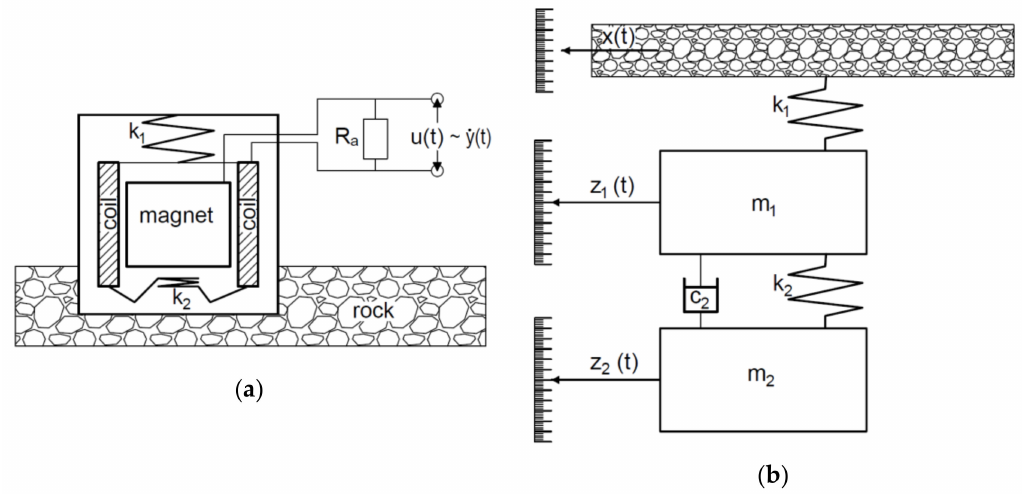
Figure 2. Diagram and principle of operation of the electrodynamic geophone: ( a ) simplified “electrical” diagram, ( b ) me- chanical equivalent diagram.